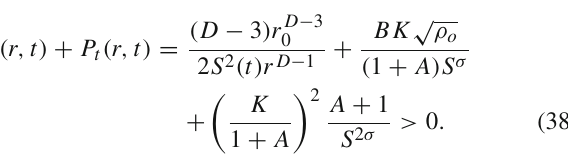
Fig. 1 Temporal variation of ρ + p r with D = 4 ( red ), 5 ( blue ), 10 ( green ) with A = 1 , B